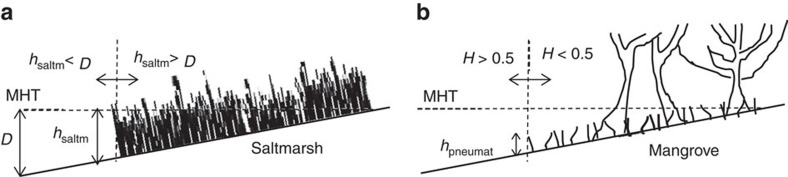
Main conditions for vegetation establishment/survival.(a) Saltmarsh establishment is limited by inundation depths D larger than its height hsaltm due to hypoxia. (b) Mangrove establishment, on the other hand, is limited by its pneumatophores being able to access oxygen at least half of the time, which is given by a hydroperiod H smaller than 0.5 at the pneumatophore height hpneumat. MHT stands for Mean High Tide.